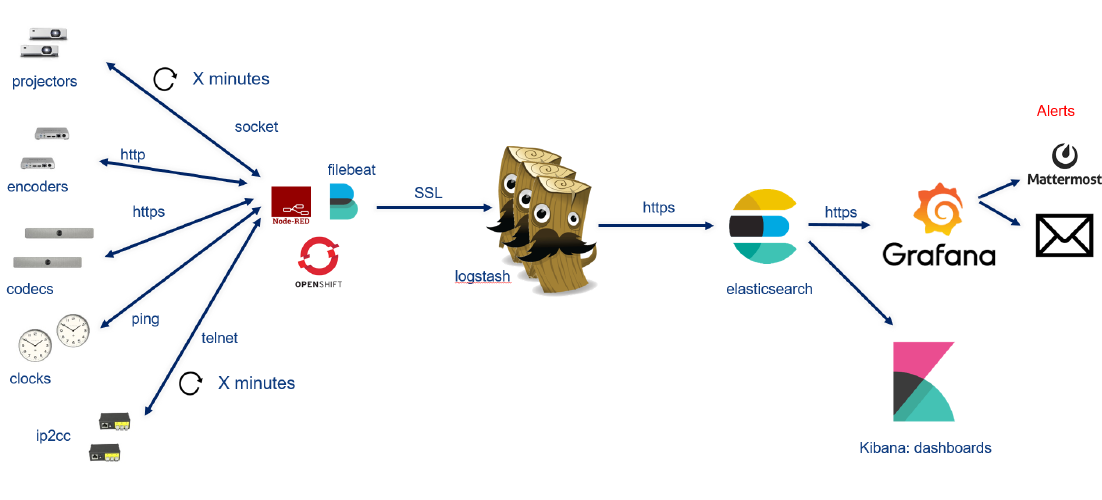
Figure 5. IoT architecture.